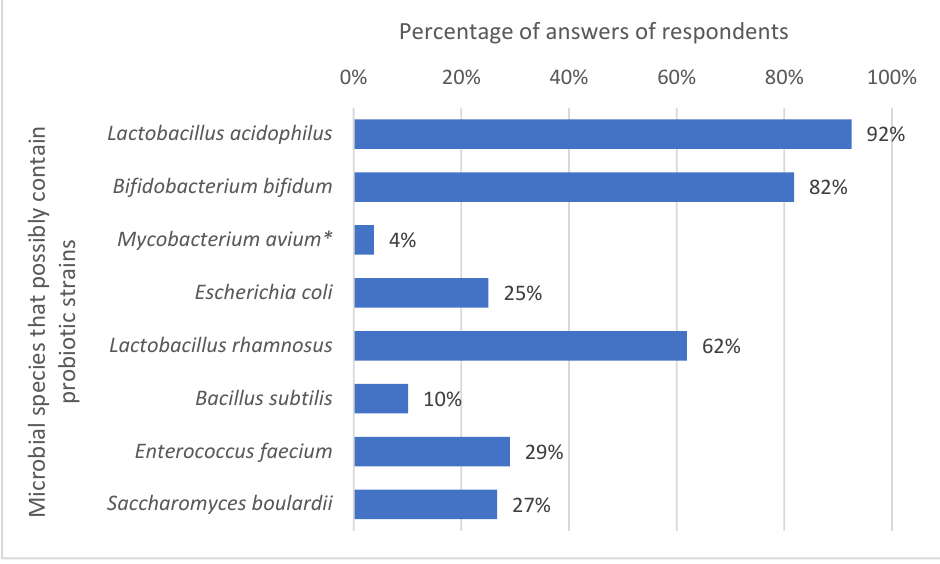
Figure 3. Respondents’ knowledge of microbial species that possibly have probiotic strains. * This species has no probiotic strains. Int. J. Environ. Res. Public Health 2019 , 16 , x FOR PEER REVIEW